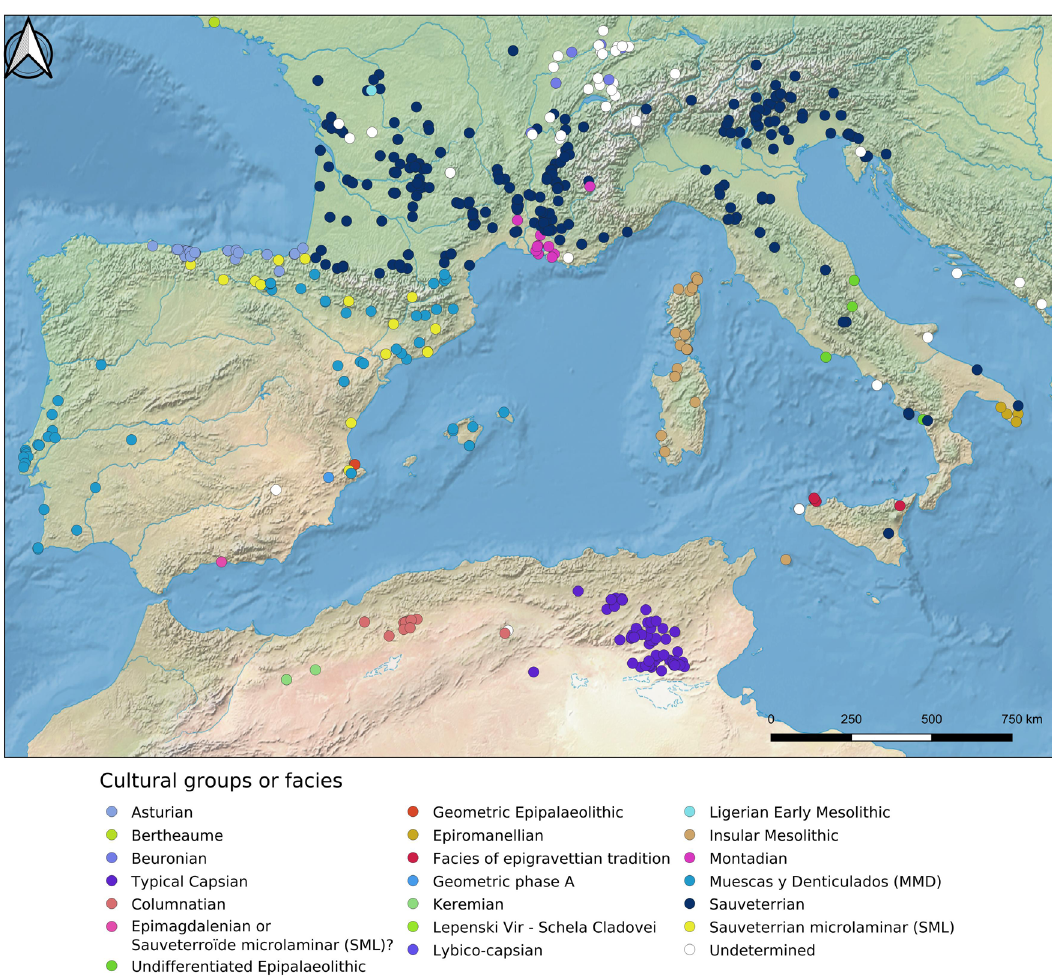
Figure 1: Map of the main facies and cultural groups of the First Mesolithic of the Western Mediterranean. Data: BDA database https://bda.huma -